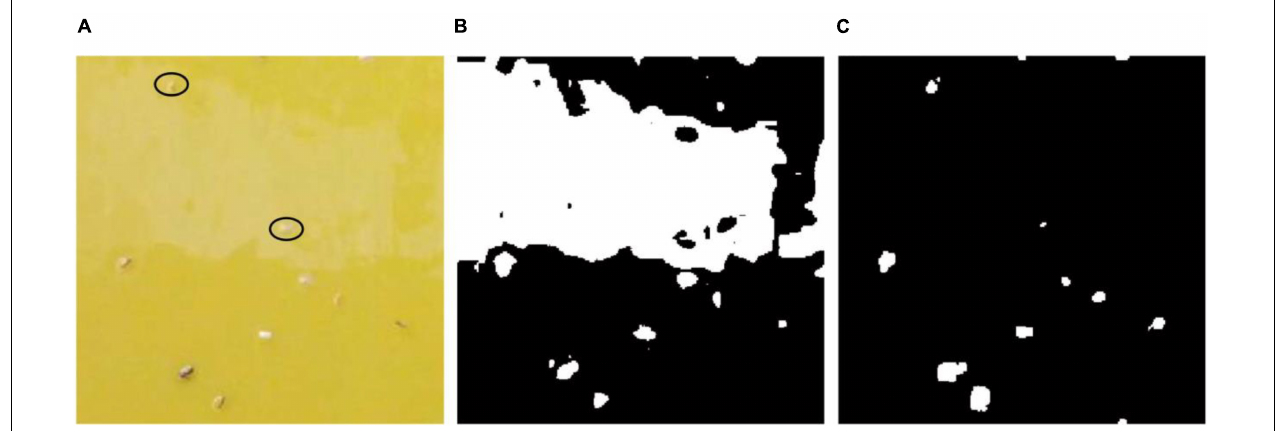
FIGURE 11 | Pest segmentation results of a sub-blocking image with noise by different methods. (A) Original image, (B) segmentation result of YCbCr color model, (C) segmentation result of the proposed method. TABLE 2 | Comparison between the proposed and previous methods for detection of whitefly and thrips using sticky trap images. Method Imaging Segmentation Features Classification scene